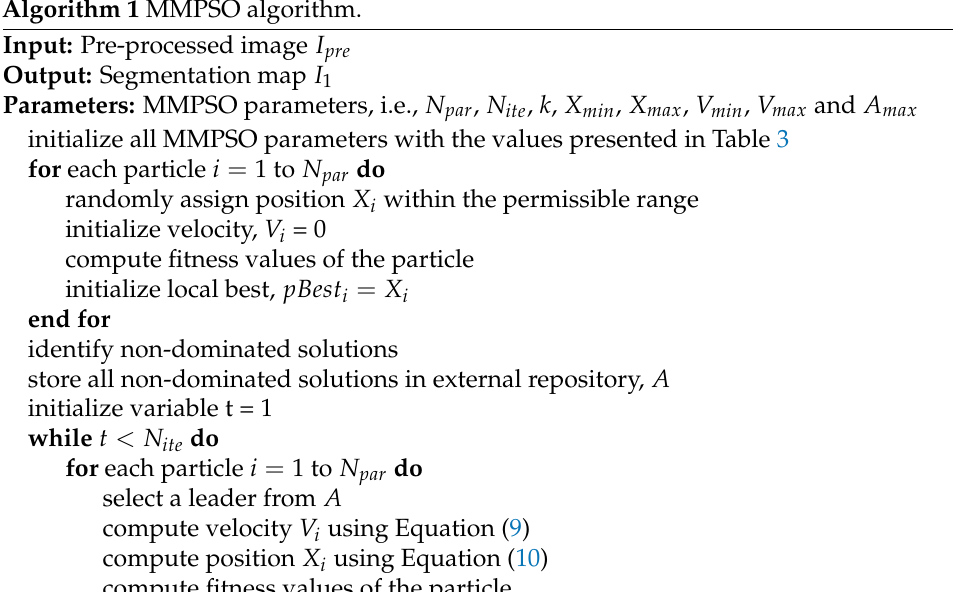
Algorithm 1 MMPSO